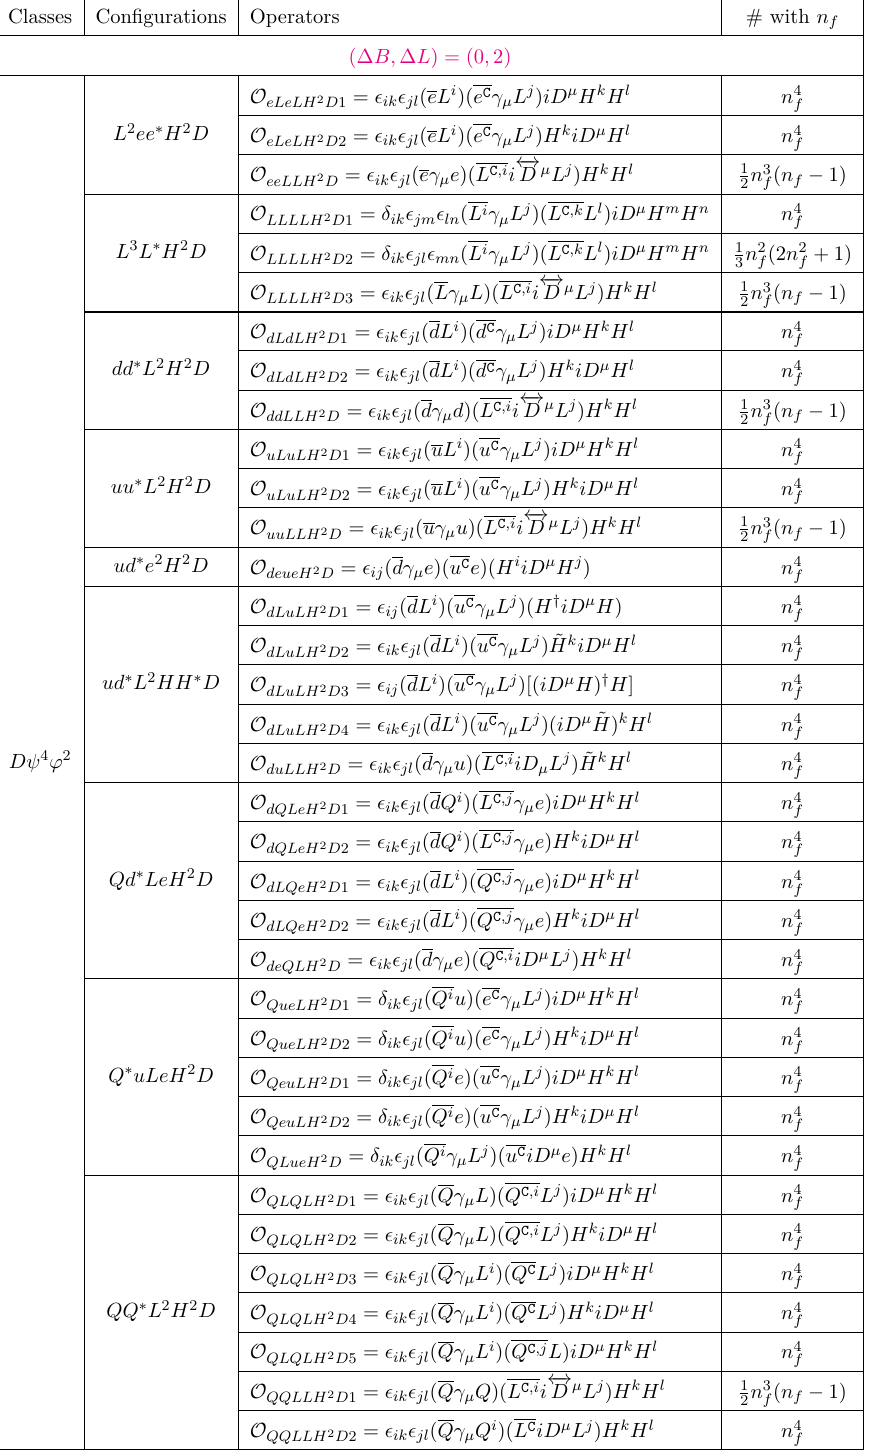
Table 4 . Dim-9 operators in class Dψ 4 ϕ 2 for sector (∆ B, ∆ L ) = (0 , 2) . There are 35 operators without counting fermion generations and 30 remain for one generation case. Hermitian conjugated operators are not included or